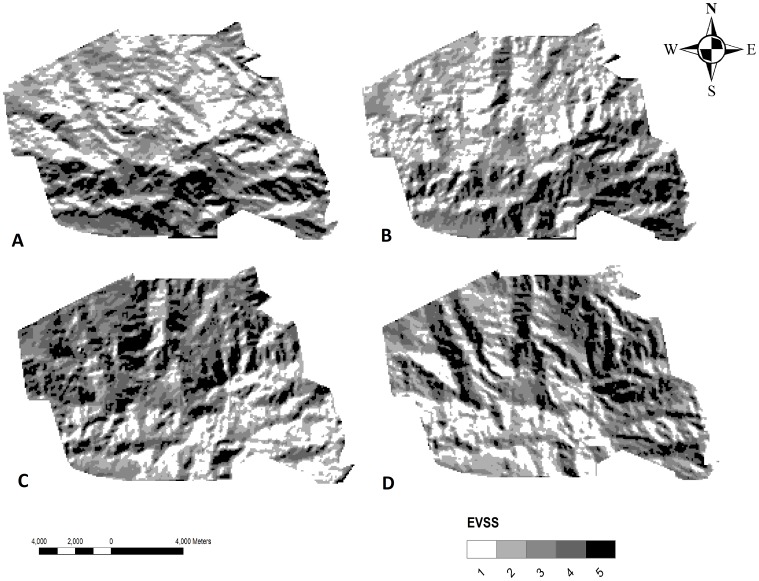
Exposure vulnerability site score maps.Exposure vulnerability site score (EVSS) maps based on equation 9, assuming an inflow angle of 20°. An EVSS of one indicates low site vulnerability and a high score high vulnerability. Note that only the wind inflow direction from the South (A), South-East (B), North-West (C) and North-East (D) are shown. EVSS’s map scores correspond to a range of approximately 28–34 (A), 23–32 (B), 5–7 (C) and 5–7 (D).